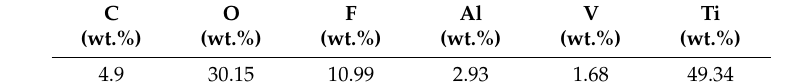
Table 2. Chemical composition of the EDS analysis realized to the sample anodized for 60 min.